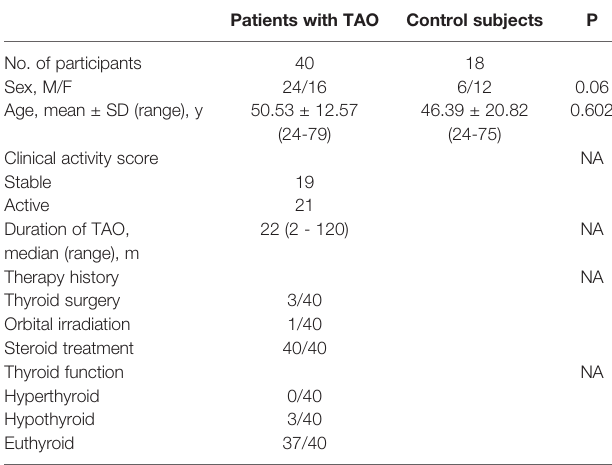
TABLE 1 | Demographic Data of Patients with TAO and